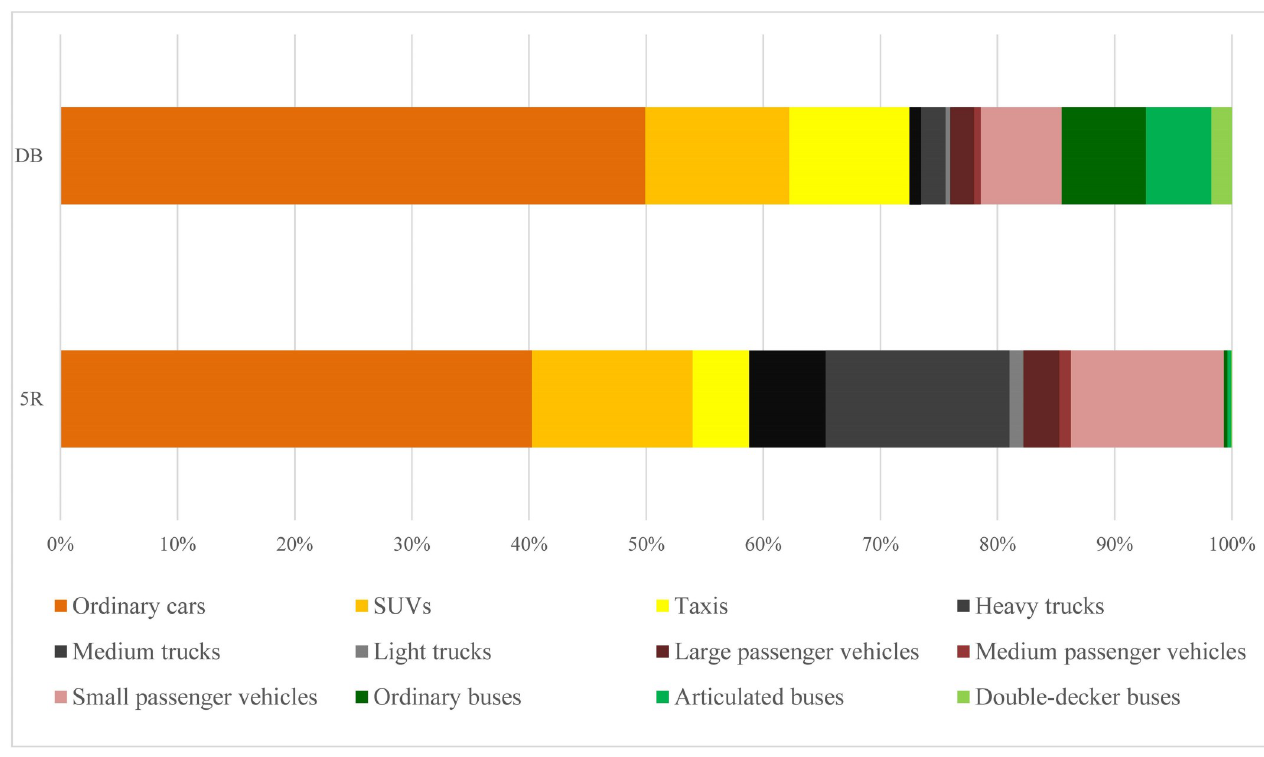
Fig 2. Structural characteristics of the traffic CO 2 emissions at 5R and DB.